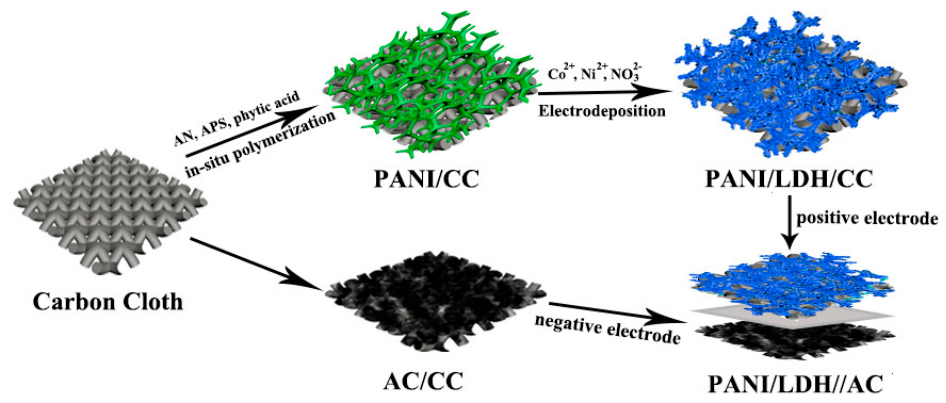
Figure 1. Schematic illustration for the preparation process of PANI/LDH/CC core-shell nanofibers and asymmetric supercapacitor.